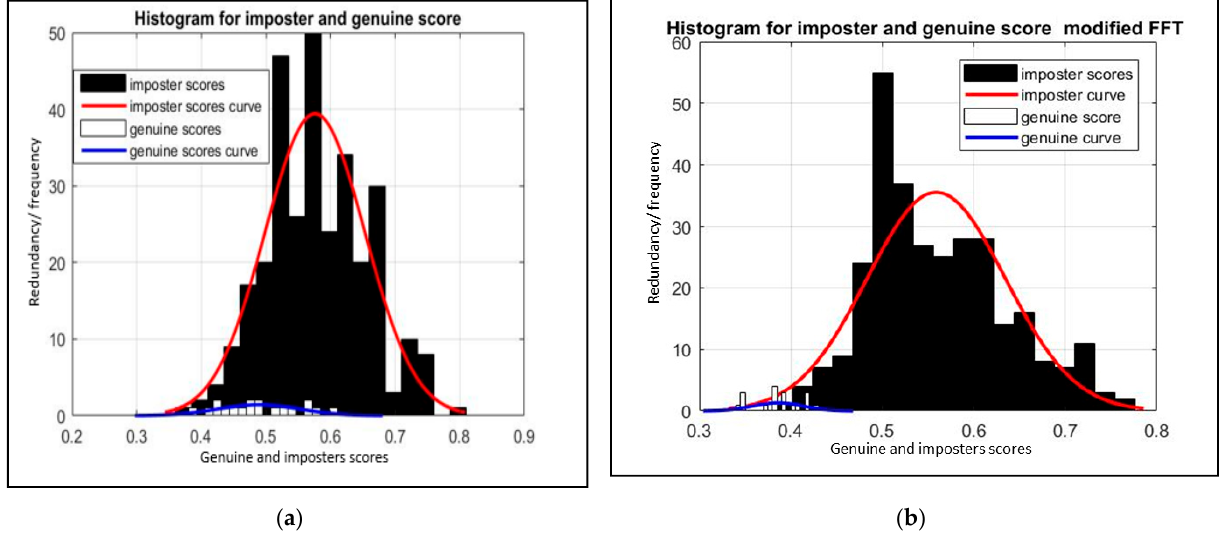
Figure 8. Histogram for the imposter and genuine scores; ( a ) the proposed method with original FFT, ( b ) the proposed method with modified FFT.